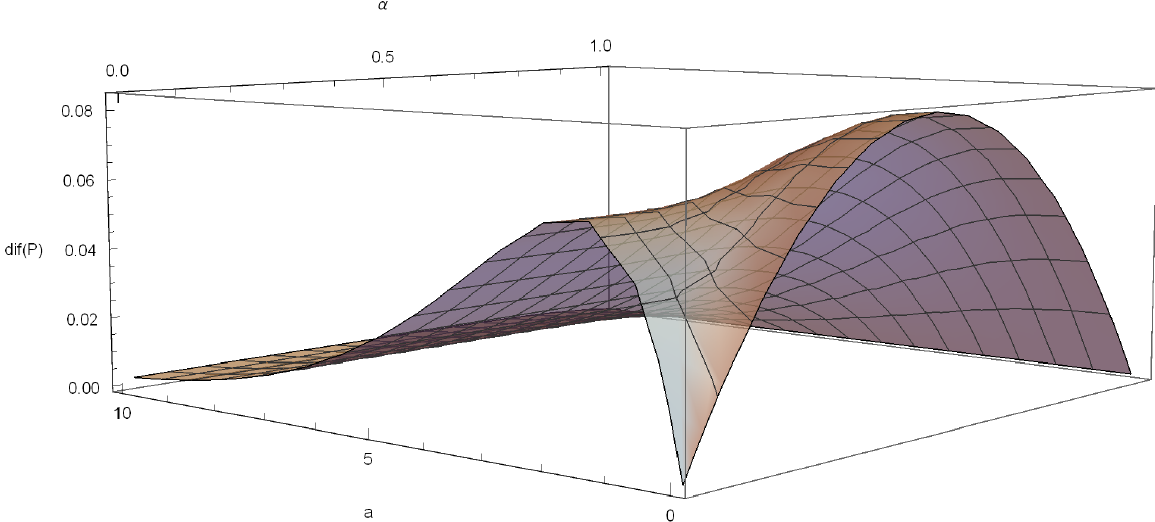
Fig 4. dif ( P ) in the Poisson-exponential case with δ = 0.03, λ = 1, γ = 0.6.